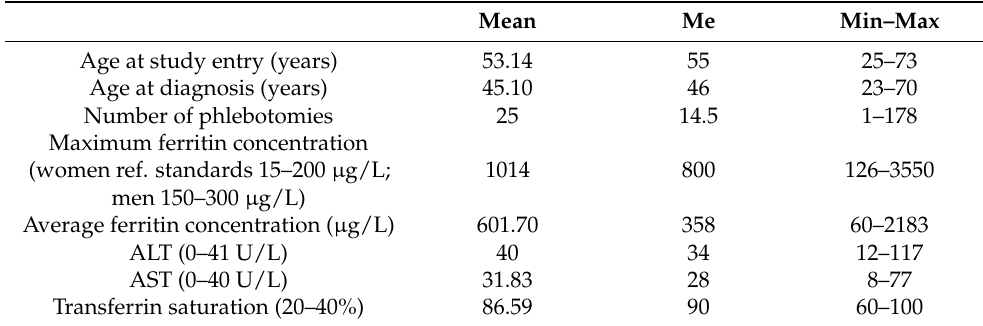
Table 1. Characteristics of the study group.